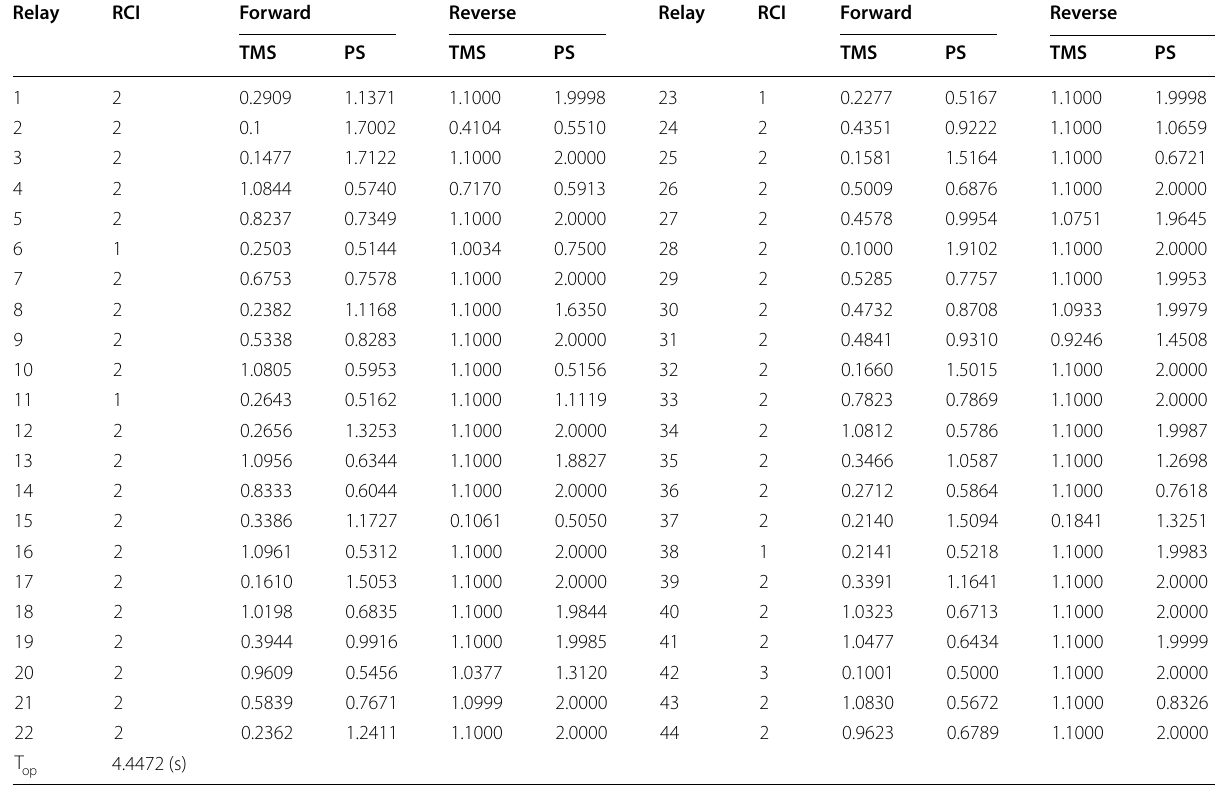
Table 10 Optimal relay setting for common operating mode in 18 bus microgrid system using GA